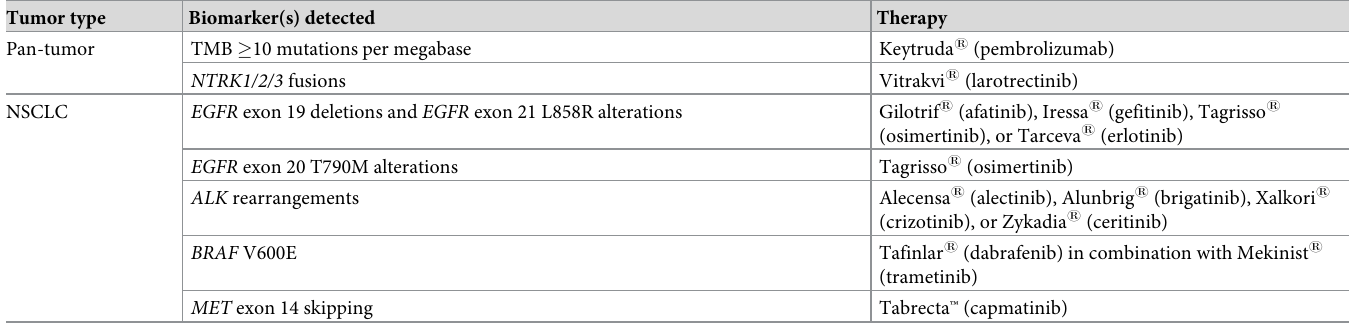
Table 1. F1CDx companion diagnostic